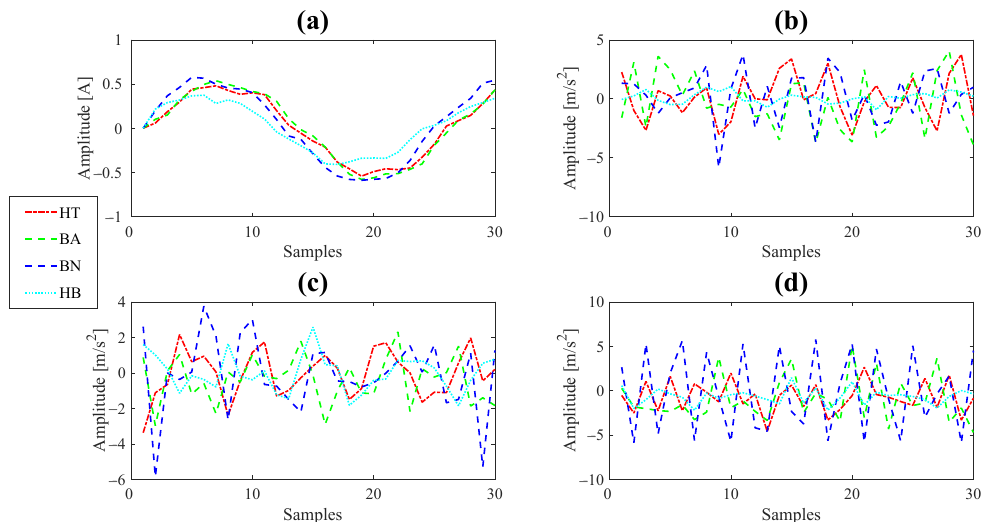
Figure 4. Signals samples. ( a ) Current signals. ( b ) x -axis vibration signals. ( c ) y -axis vibration signals. ( d ) z -axis vibration